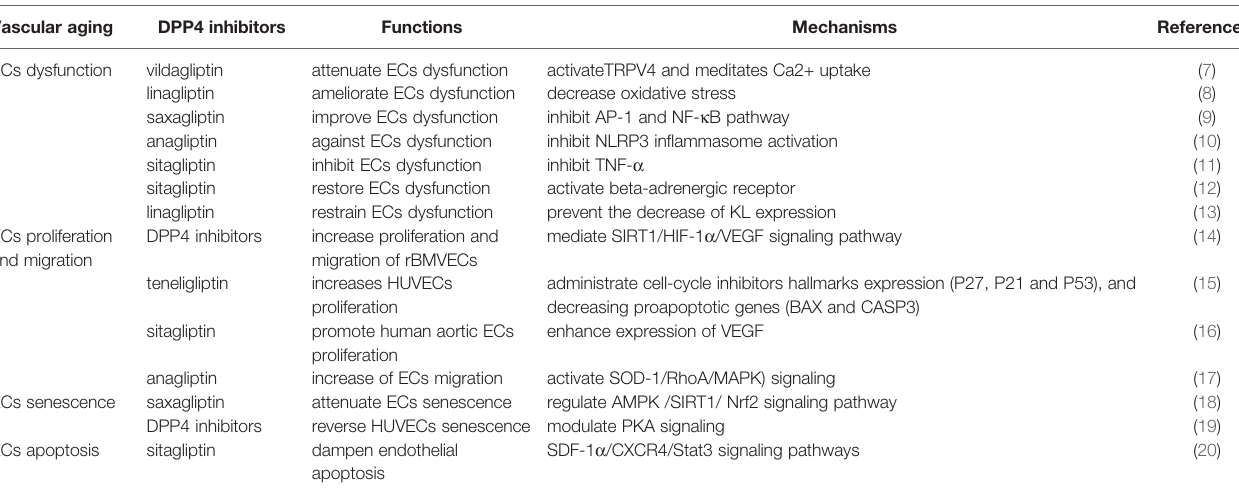
TABLE 1 | DPP4 inhibitors associated with vascular function and mechanisms in ECs